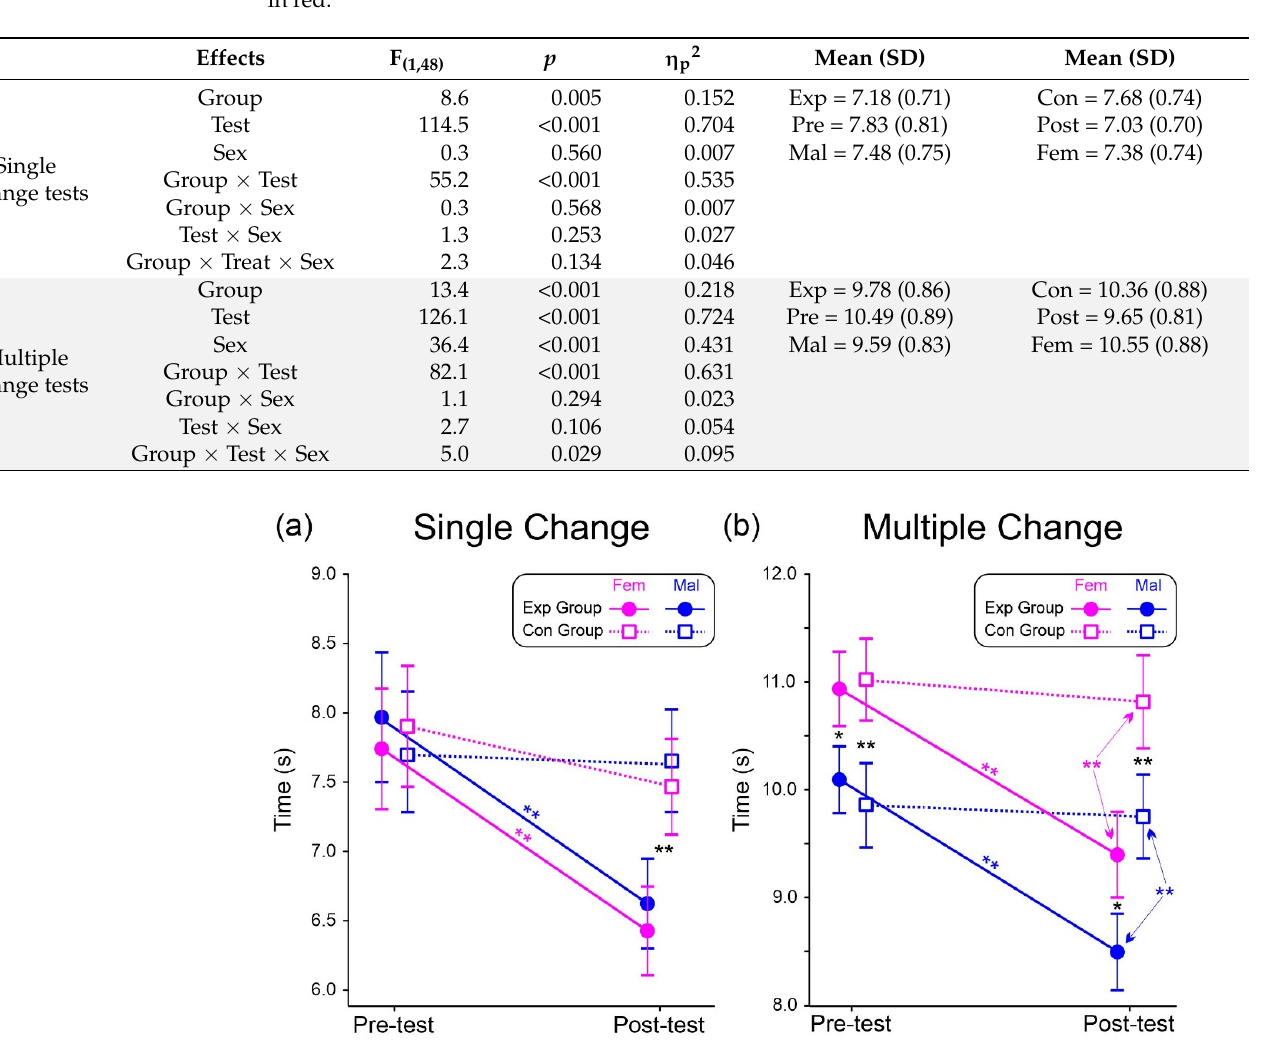
Figure 3. Results in basketball tests. ( a ) Single change tests completion time. ( b ) Multiple change tests completion time. Vertical bars indicate 0.95 confidence intervals. * p < 0.05, ** p < 0.01.